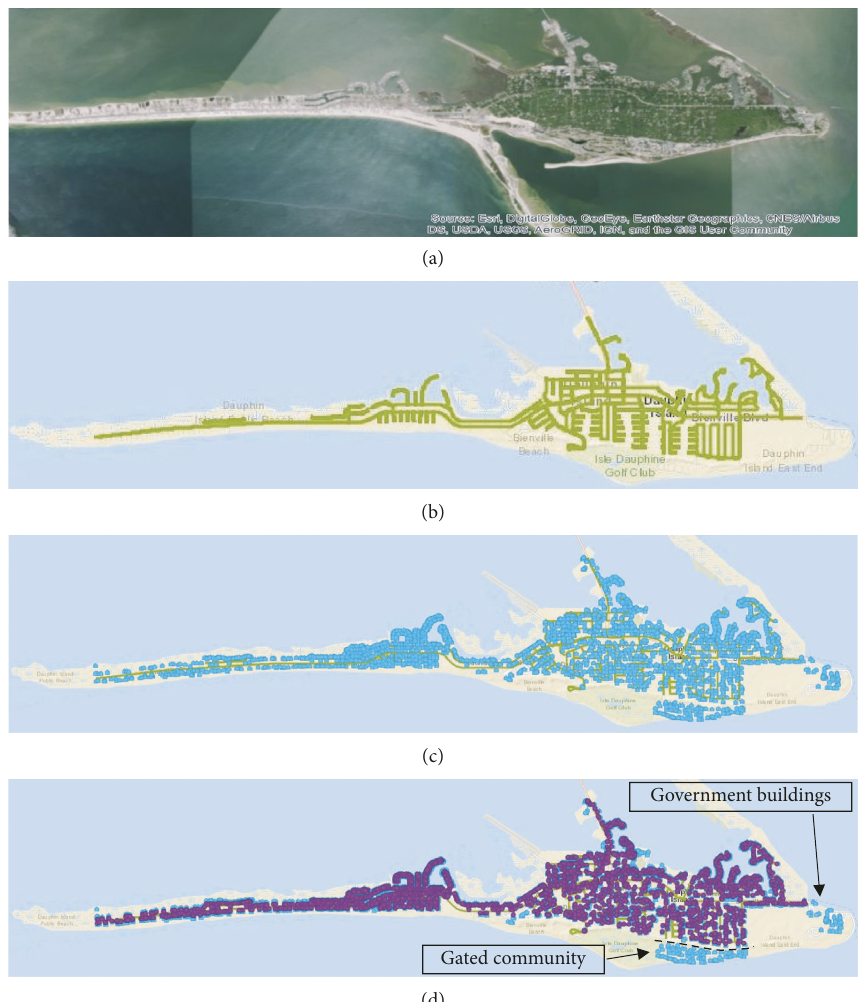
Figure 7: Dauphin Island with (a) aerial overview, (b) collected video paths, (c) building locations, and (d) survey locations storing extracted